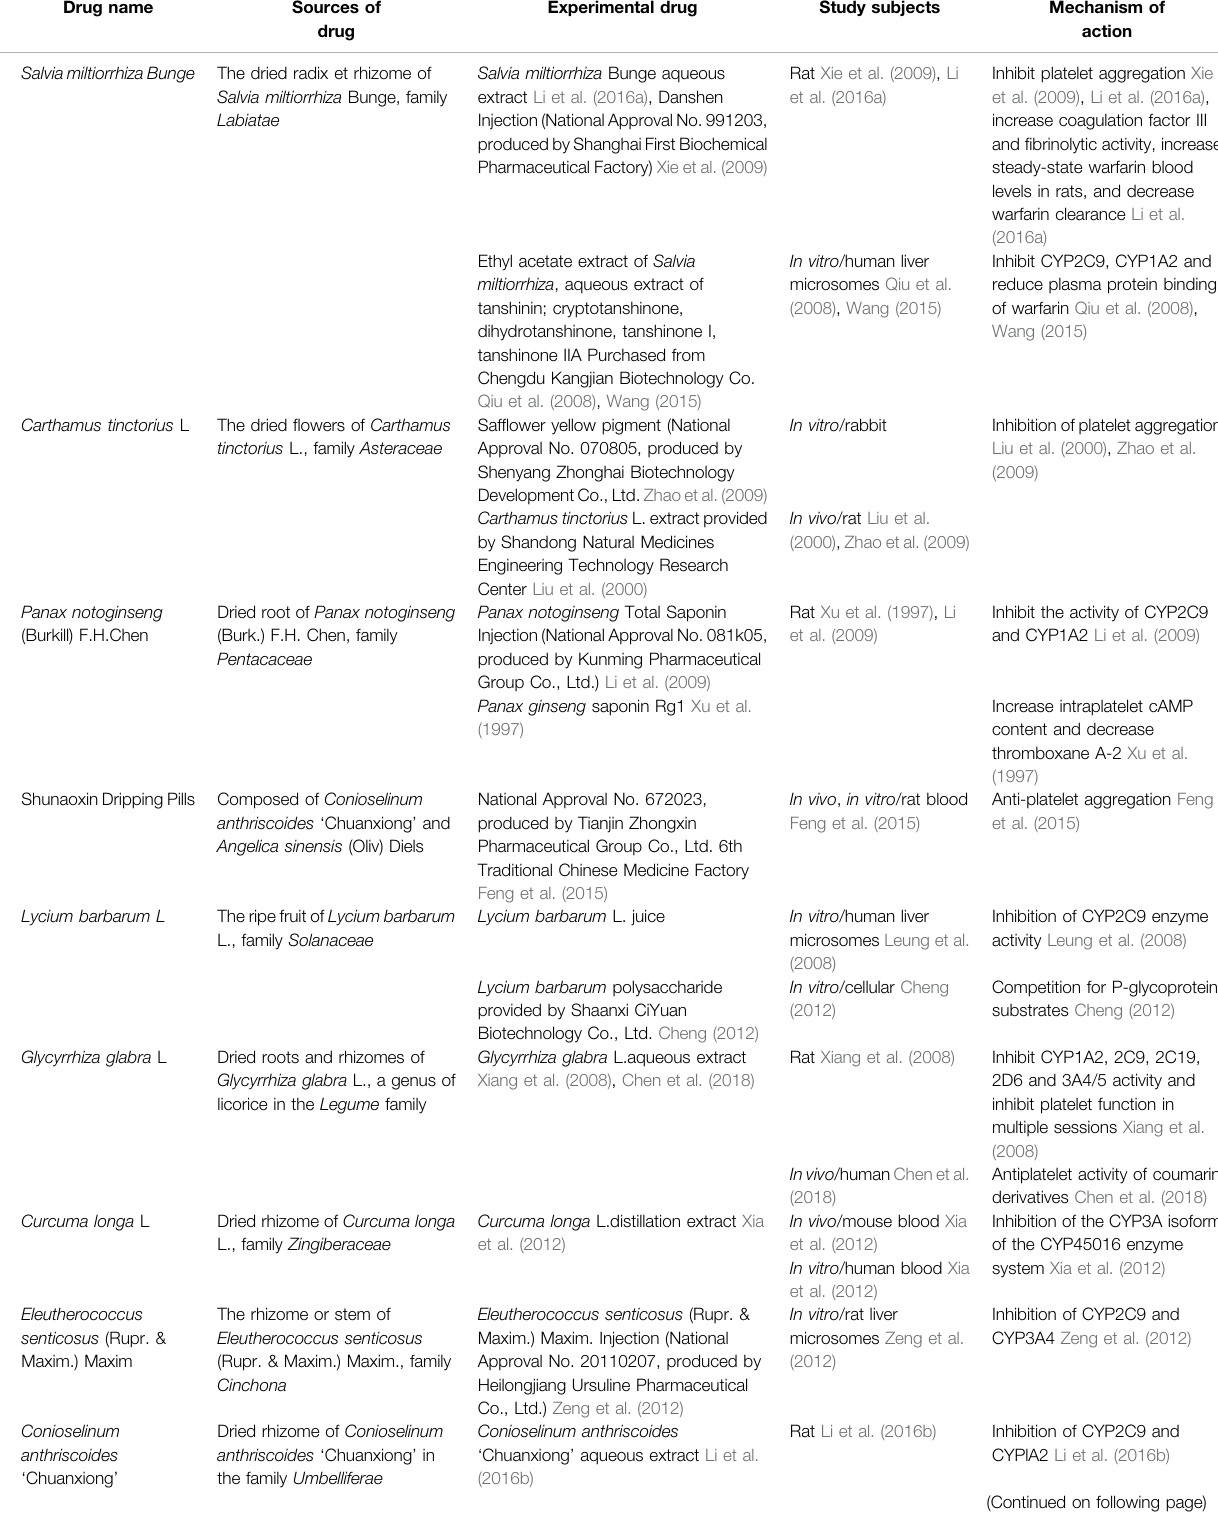
TABLE 1 | The mechanism of the enhancement or weakening of the anticoagulant effect of Chinese medicines on warfarin. Drug